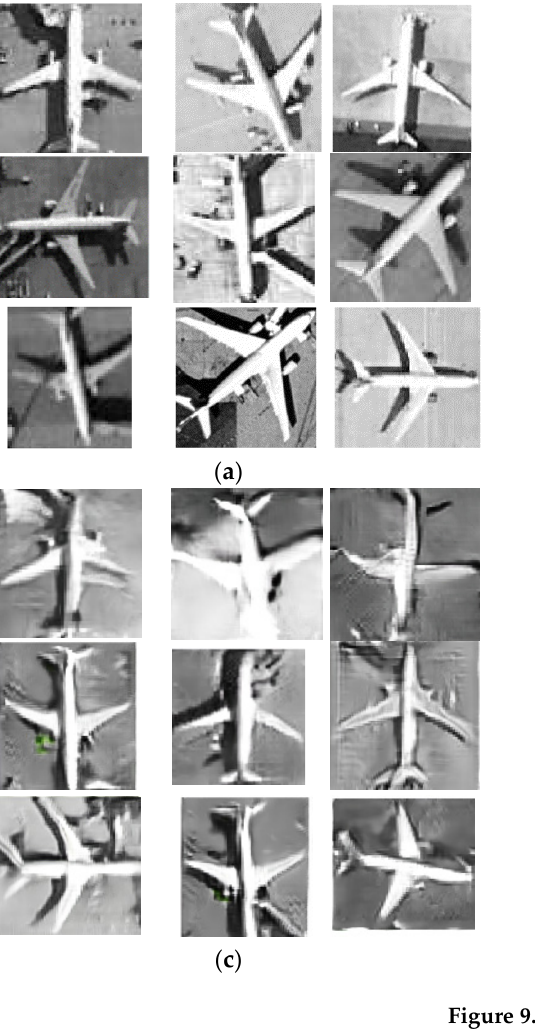
Figure 8. Generated pictures of modified shuffle attention GAN with and with equal stretch resize method. ( a ) Generated pictures with original resize method; ( b ) generated pictures with the equal stretch resize method.